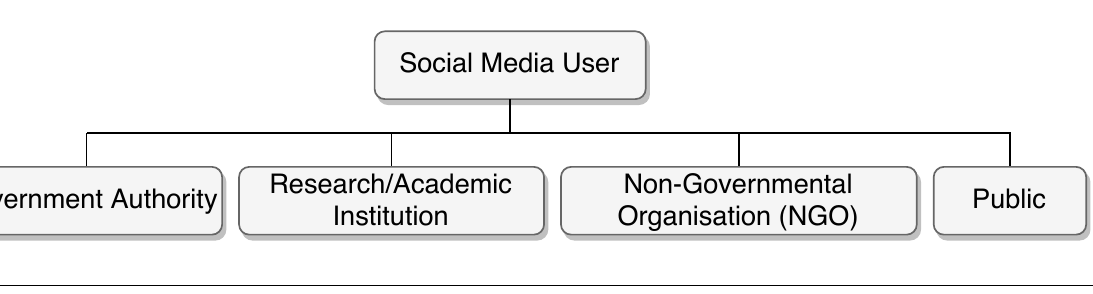
Figure 2. Social media